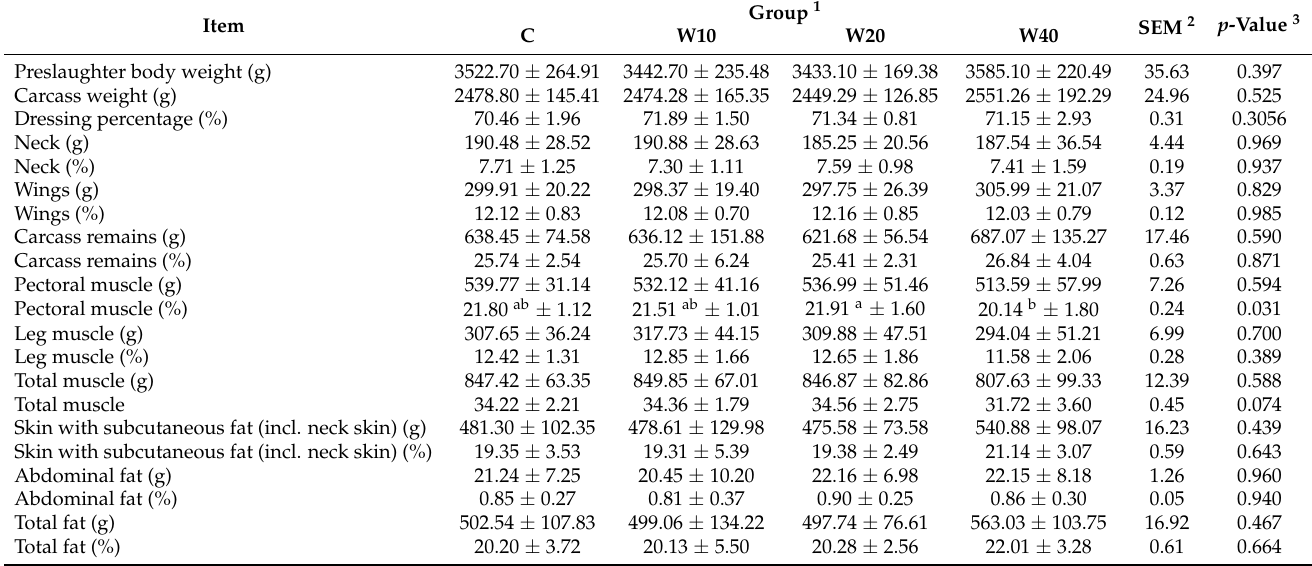
Table 4. Carcass features of broiler ducks after 7 weeks of